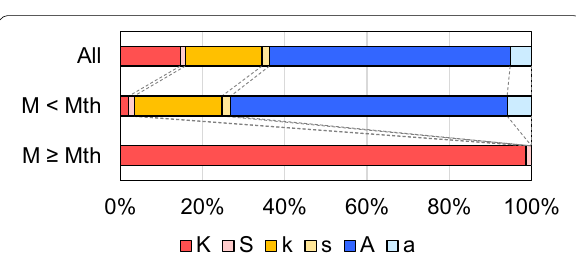
Fig. 5 Proportion of flags in the JMA unified catalog since April 2016. All, full range of magnitudes; M < M th, small events not requiring full inspection; M M th, relatively large events requiring full ≥